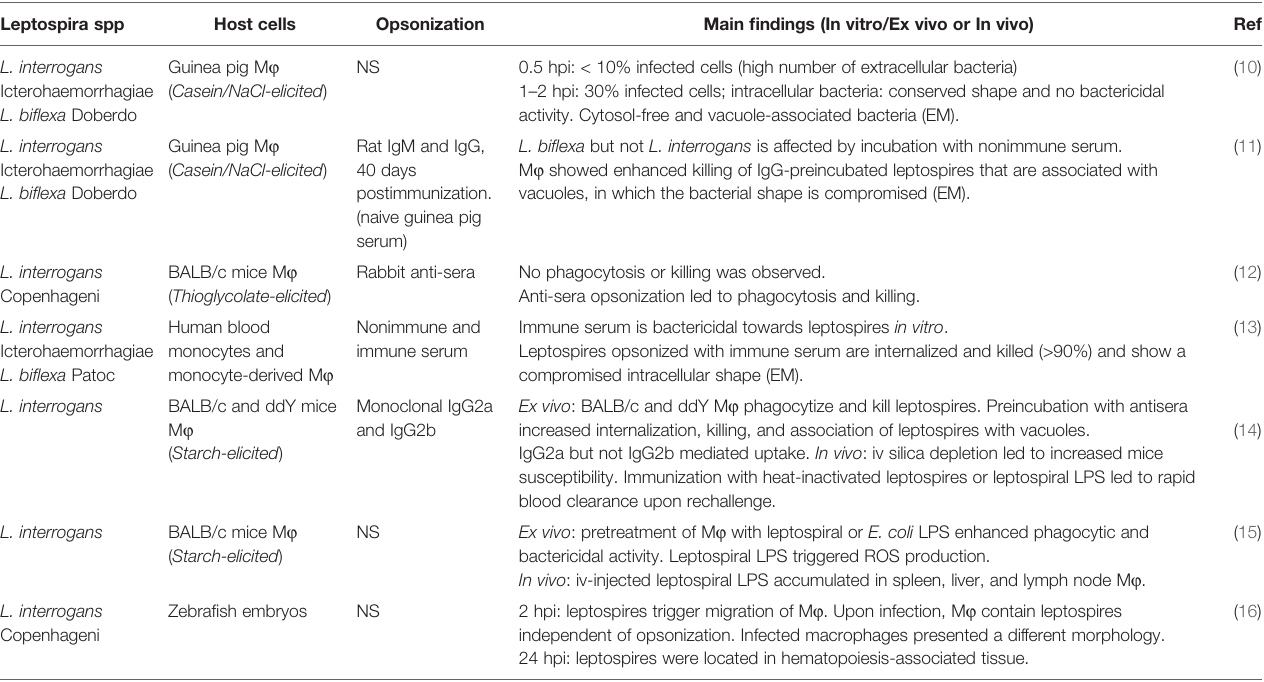
TABLE 1 | Opsonization of